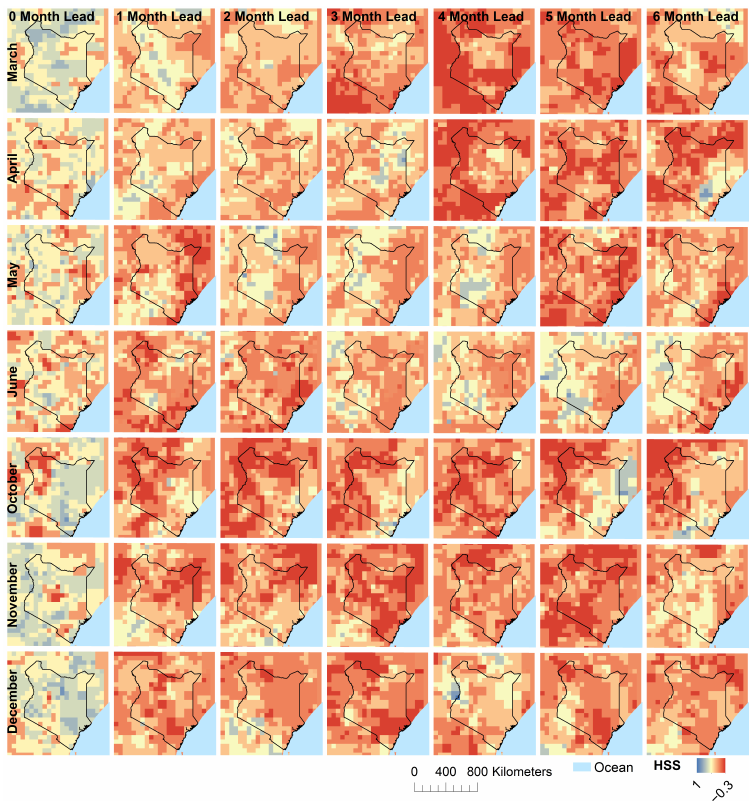
Figure 9. This image shows the Heidke skill score over individual months for dry anomaly events.